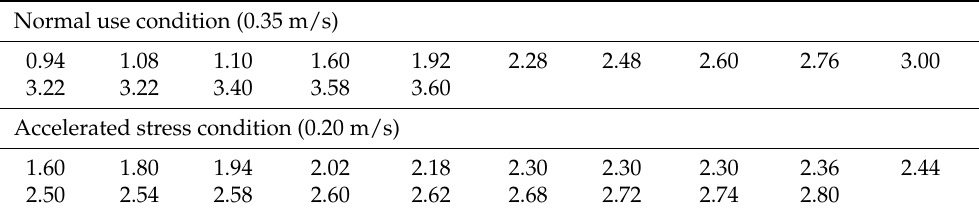
Table 2. Times of micro-droplets in the air.